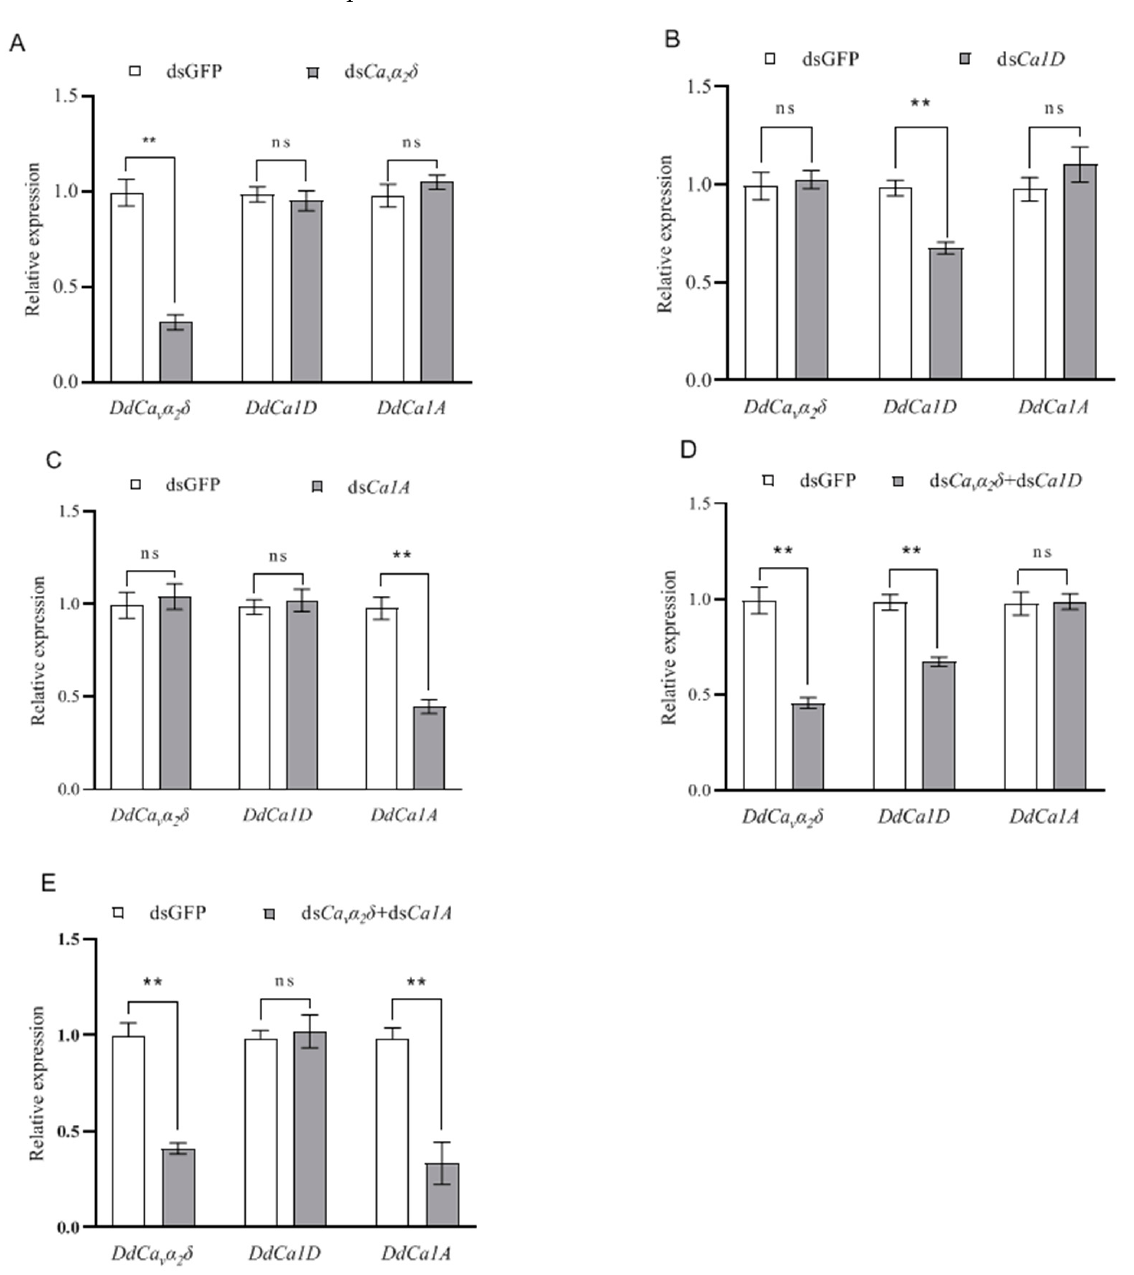
Figure 7. Effect of different dsRNA soaking solutions on the expression level of DdC α 1D , DdC α 1A , and DdCa v α 2 δ genes. Control nematodes were soaked in the solution containing non-target GFP dsRNA. ( A ) Nematodes treated with DdCa v α 2 δ dsRNA. ( B ) Nematodes treated with DdC α 1D dsRNA.